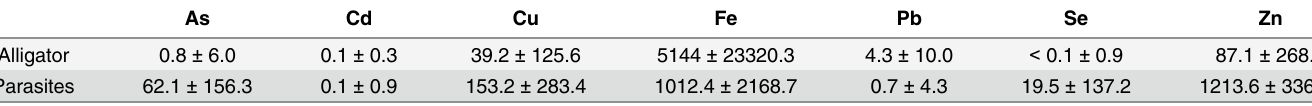
Table 2. Average heavy metal concentrations (mg/kg) in alligators and parasites (mean ± standard deviations). As